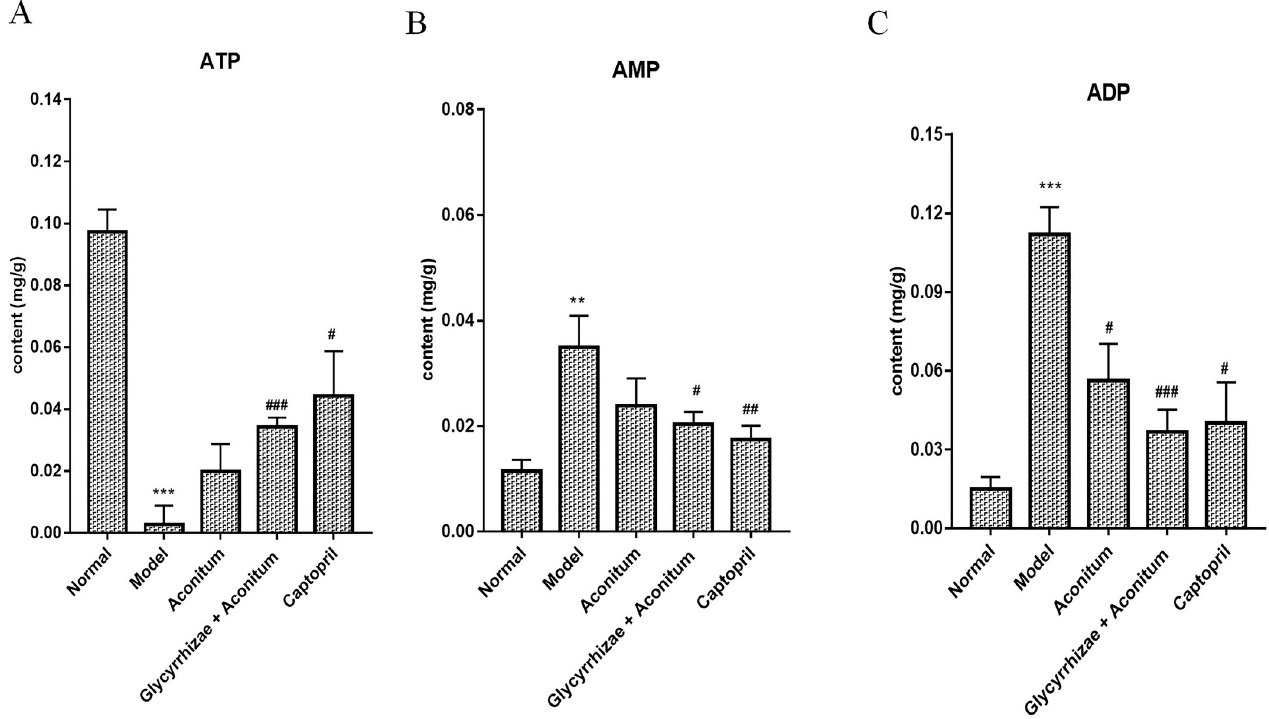
Fig 8. The intervention effect of Aconitum and the compatibility of Glycyrrhizae and Aconitum on serum ATP, AMP and ADP levels. The rat model of CHF was established by intraperitoneal injection of ADR (2.5 mg / kg). The rats were randomly divided into model group, Aconitum (0.3 g / mL) group, Glycyrrhizae with Aconitum (0.6 g / mL) group and Captopril (1.25 mg / mL) group. Each treatment group was given 5 mL / kg / D by gavage for 4 weeks, the normal group and model group were given the same volume of distilled water by gavage. (A) The content of ATP in left ventricular myocardium of rats determined by HPLC. (B) The content of AMP in left ventricular myocardium of rats determined by HPLC. (C) The content of ADP in left ventricular myocardium of rats determined by HPLC. Compared with the normal group, �� P < 0.01; ��� P < 0.001; Compared with the model group, #P < 0.05; ##P < 0.01; ###P <